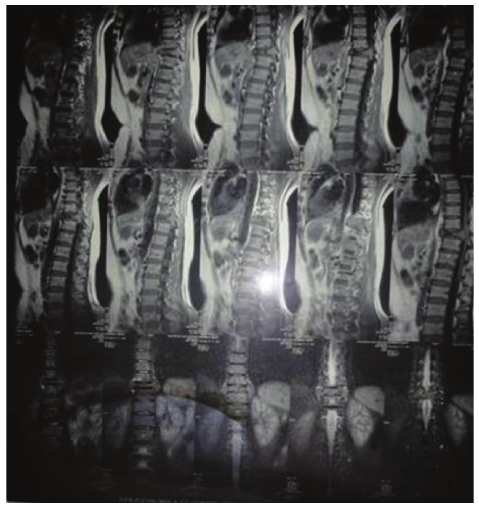
Figure 3: MRI of dorsolumbar spine showing complete marrow replacement of vertebral body and posterior elements with asso- ciated homogenously enhanced soft tissue component in adjacent pre- and paravertebral space and in ventral and dorsal epidural spaces leading to severe cord compression and spinal canal